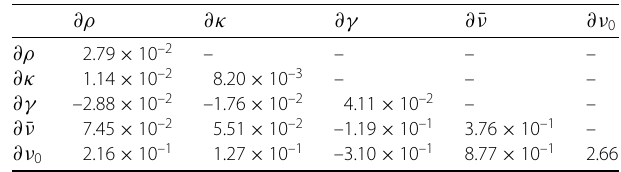
Table 9 A Hessian matrix at the true value set Θ ∗